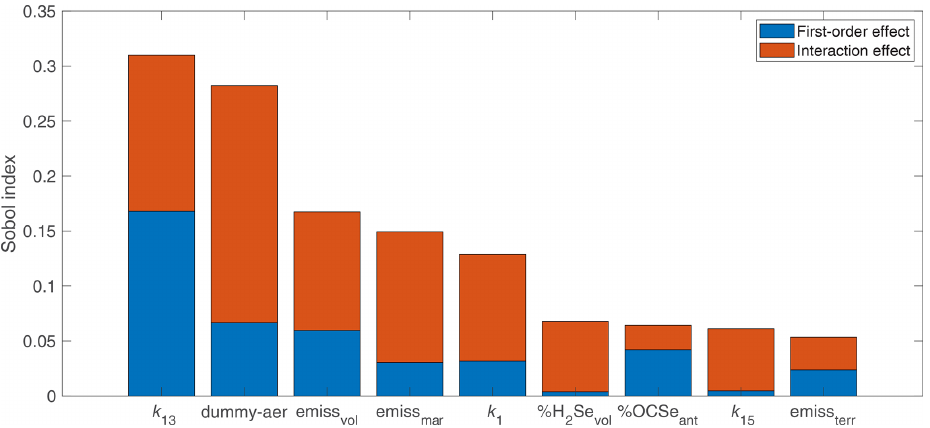
> 0 . 05) for the atmospheric Se lifetime. Total Sobol’ indices are parti- Figure 5. Sensitivity indices of the most important parameters ( S T i tioned into first-order and interaction effects. The total Sobol’ indices for the dummy aerosol parameters are aggregated, since it is difficult to separate the effects of the correlated input parameters (aerosol radius and emission